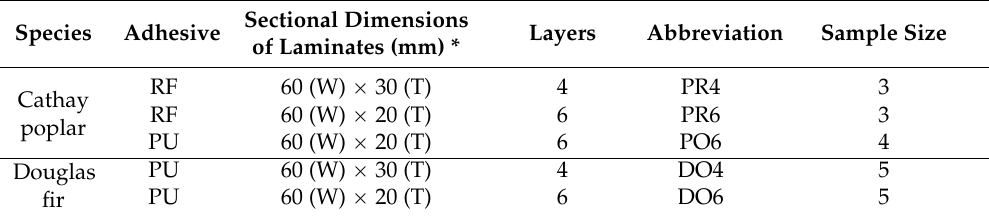
Table 2. Specimen parameters. RF, resorcinol formaldehyde; PU, polyurethane; W, width; T, thickness. Species